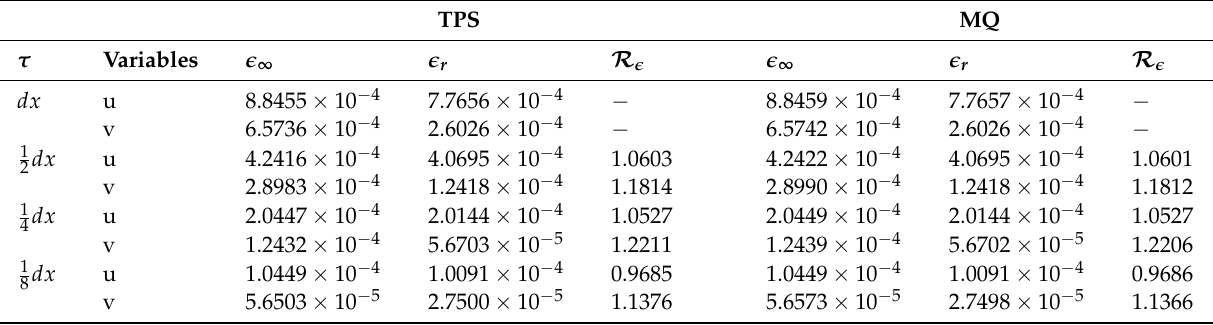
Table 8. Error estimates and CPU times of Example 3 by letting dx = 1 values of τ